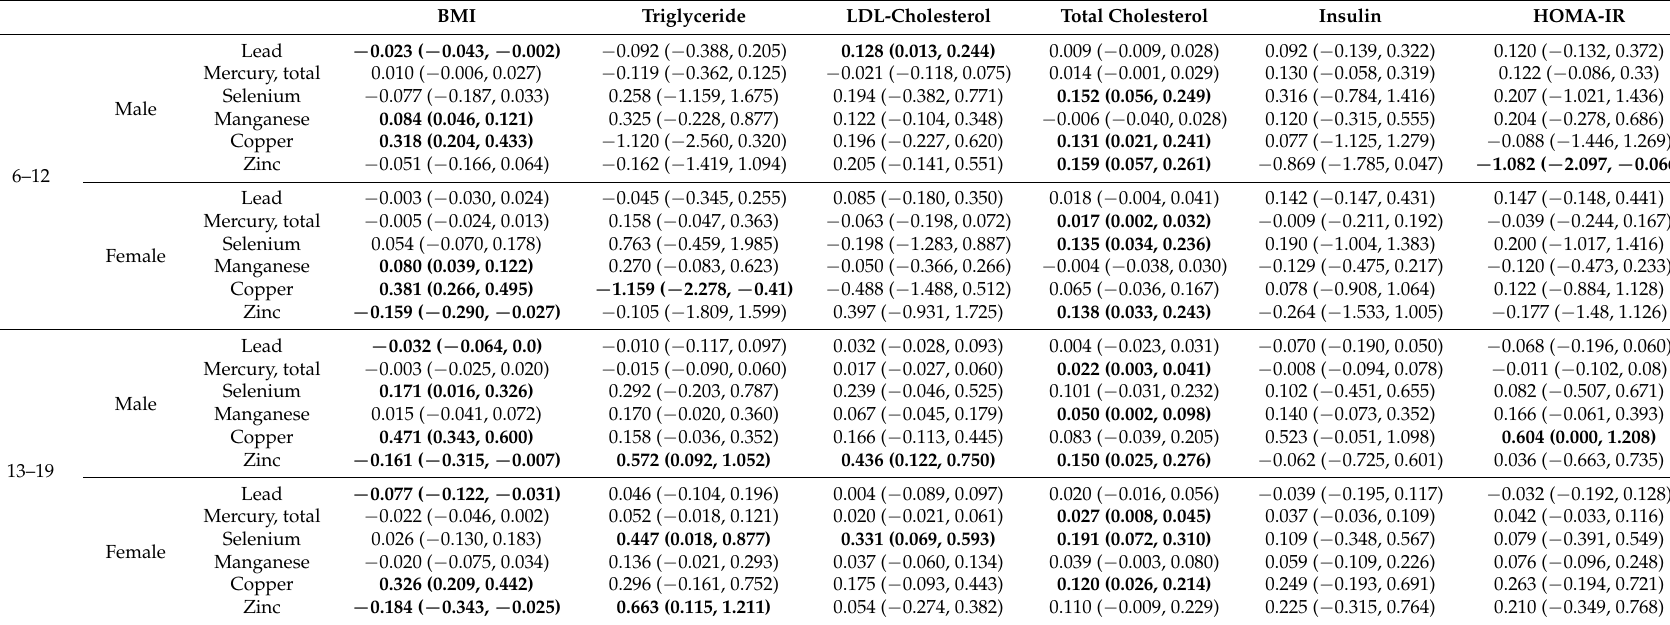
Table 3. Adjusted regression coefficient ( β ) and 95% Confidence Intervals (95% CI) in BMI and serum metabolites and serum metals stratified by age and